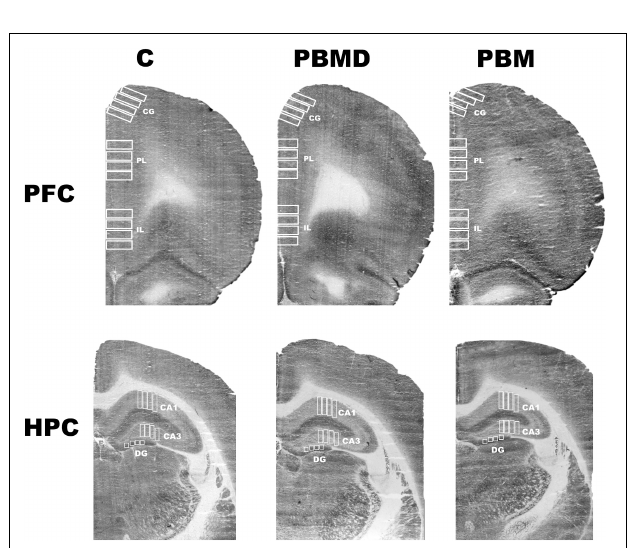
FIGURE 2 | CCO samples. Representative photograph of the CCO optical density of the three groups (C, PBMD, and PBM) in PFC and HPC. There were no differences between groups in any of the studied regions in male or female samples. Groups: C, control group; PBMD, photobiomodulation device group; PBM, photobiomodulation group. Areas: CG, Cingulate cortex; PL, Prelimbic cortex; IL, Infralimbic cortex; CA1, field CA1 of hippocampus; CA3, field CA3 of hippocampus; DG, Dentate Gyrus. PFC, prefrontal cortex; HPC, hippocampus; PND, postnatal day; CCO, cytochrome c oxidase.